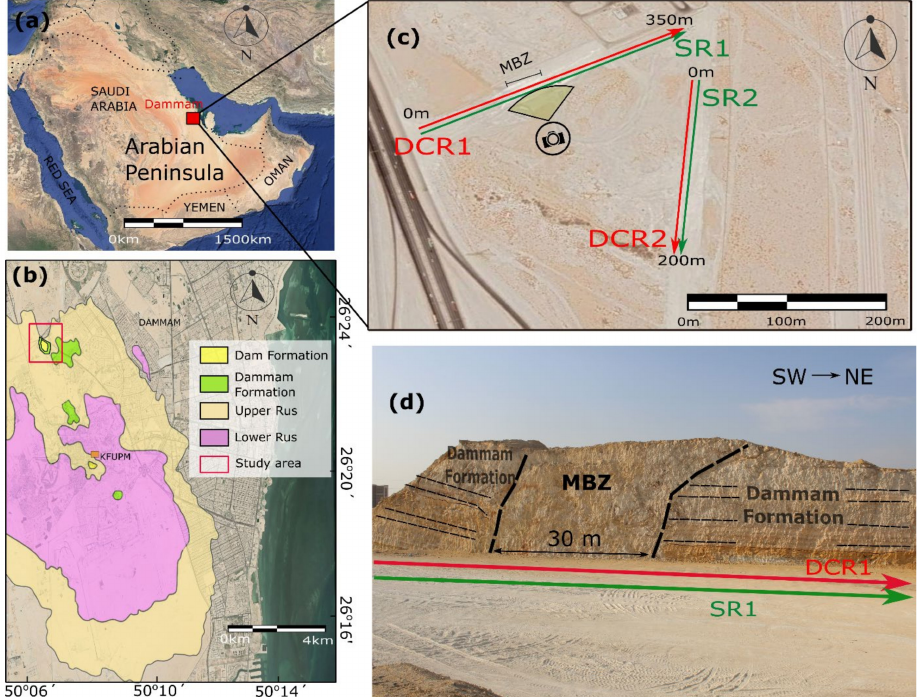
Figure 1. ( a ) Satellite image of the study area and ( b ) geological map of the wider study area (modified from Weijermars [4]). Red rectangle shows the study area; ( c ) Field view of the wide ‘megabreccia’ zone (MBZ) disrupting the sedimentary rocks of the Dammam Formation along the roadcut. The location from where the photo for figure ( c ) is taken, is shown. The DCR and SR profiles performed herein are shown with red (DCR1, DCR2) and green (SR1, SR2) lines; ( d ) The stratigraphy of the Dammam formation and the disruption (MBZ) zone of the sedimentary sequence are presented. The DCR1 (red arrow) and SR1 (green arrow) profiles collected along the under-construction road are